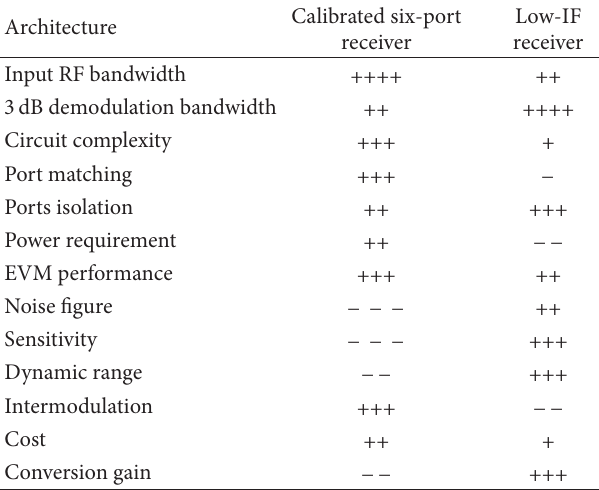
Table 6: Summary of the